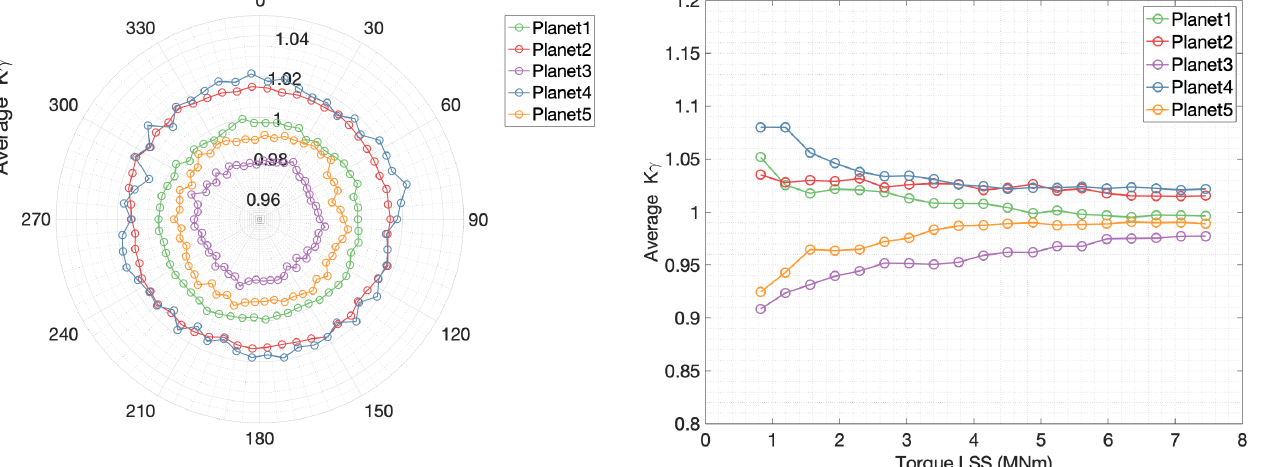
Figure 10. Average K γ vs. torque for the strain sensor S52.